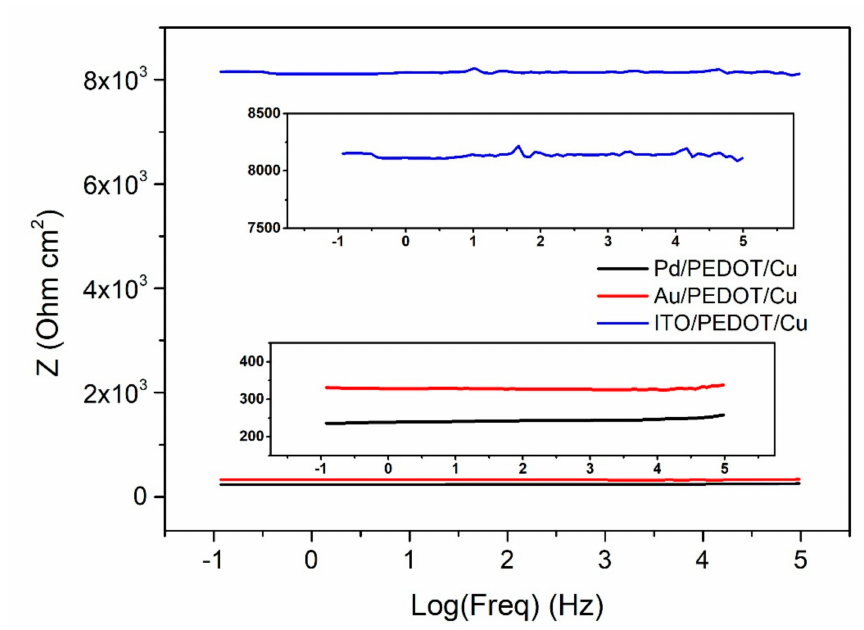
Figure 7. Bode plot of the PEDOT/Cu device, obtained on the three different substrates (Pd in black, Au in red, ITO in blue). Areas of interest are magnified in the two insets, which help in visualizing the Z